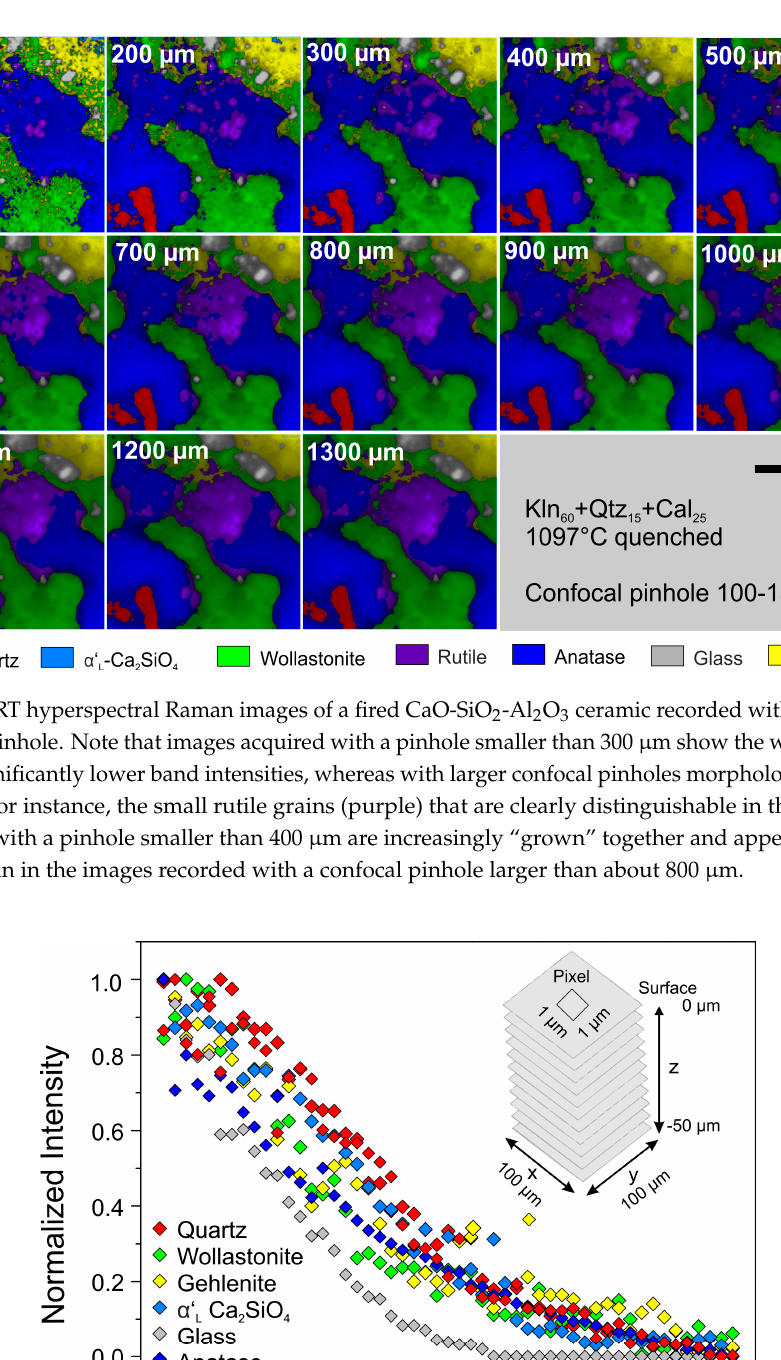
Figure 10. Normalized intensities of the main Raman band of the respective phase at six x-y positions as a function of nominal depth ( z = 0, focus at the sample surface). The data was extracted from 50 hyperspectral Raman images of a fired ceramic that were recorded at RT at a focal depth between 0 and − 50 µm ( z -axis) with a step size of 1 µm (inset diagram) and a confocal hole of 300 µm. This is also reflected by the observation that the Raman images recorded at different nominal depths from the surface ( z = 0 µm) to a depth of z = − 15 µm are very similar (Figure 11). As a matter of fact, the statistical variations of the average mineral fractions, obtained from all 16 images, are in the same order of magnitude of those that were estimated from multiple images that were recorded from the same area (volume) with identical focus (cf. Section 2.6.3). It follows that slight variations of the focus among different images (e.g., due to failing autofocus, shrinking or expansion of the sample during image acquisition) do not significantly affect the recorded mineral fractions and morphological details (e.g., the location of grain boundaries).